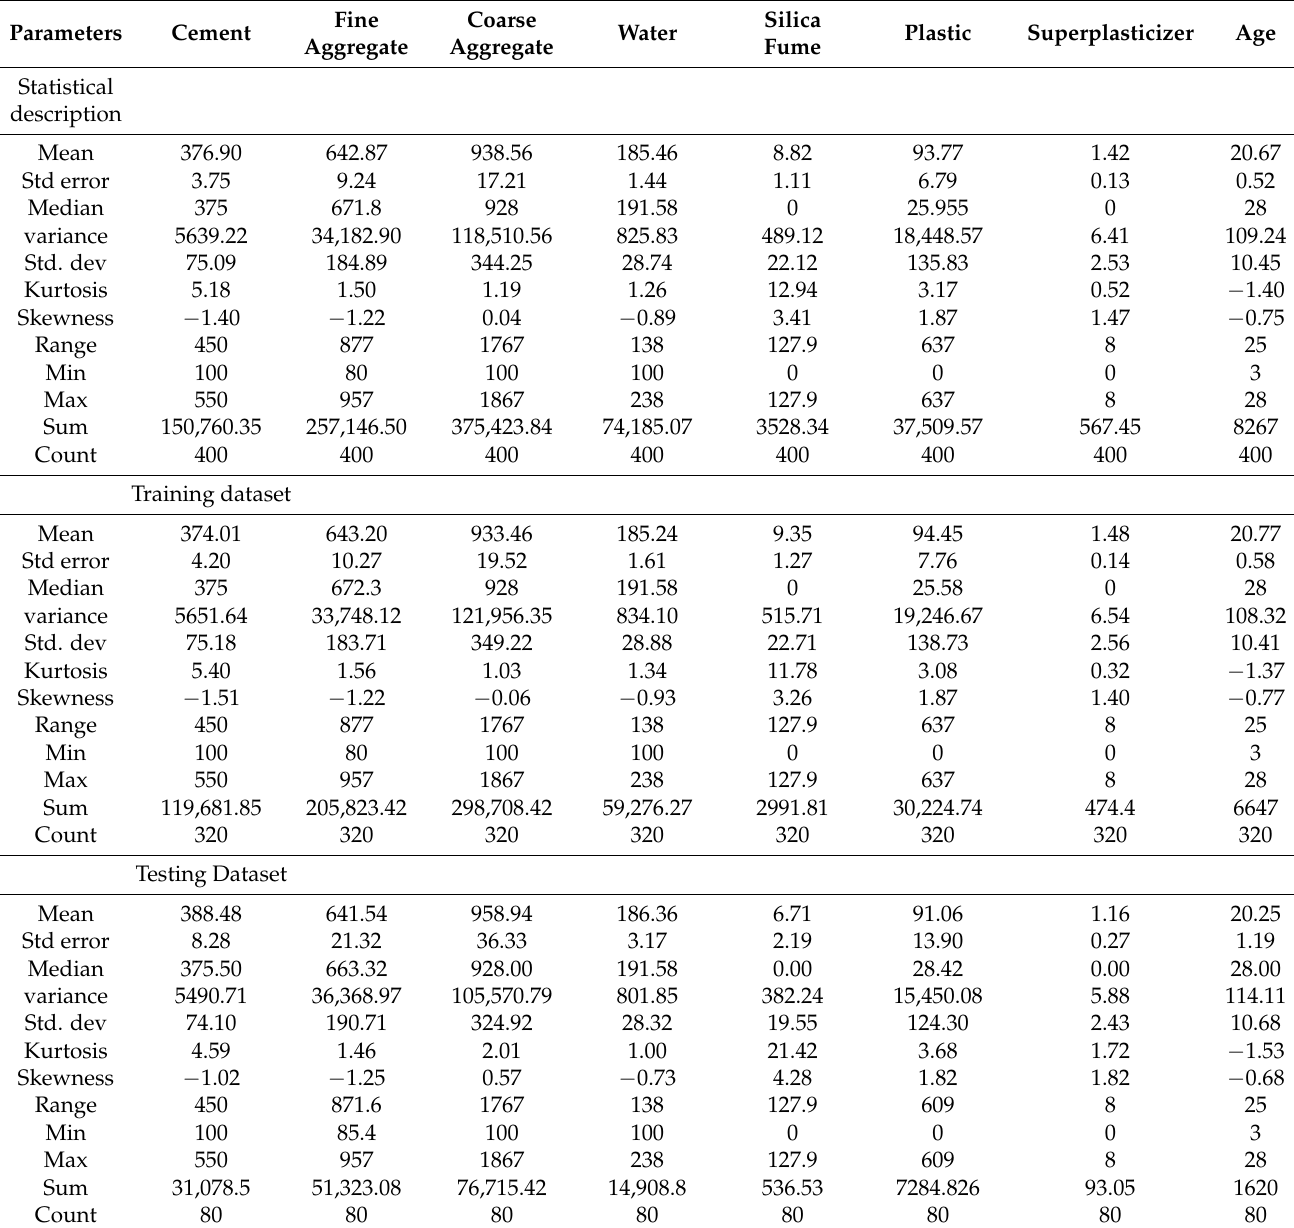
Table 5. Data statistical description for compressive strength model’s parameters (kg/m 3